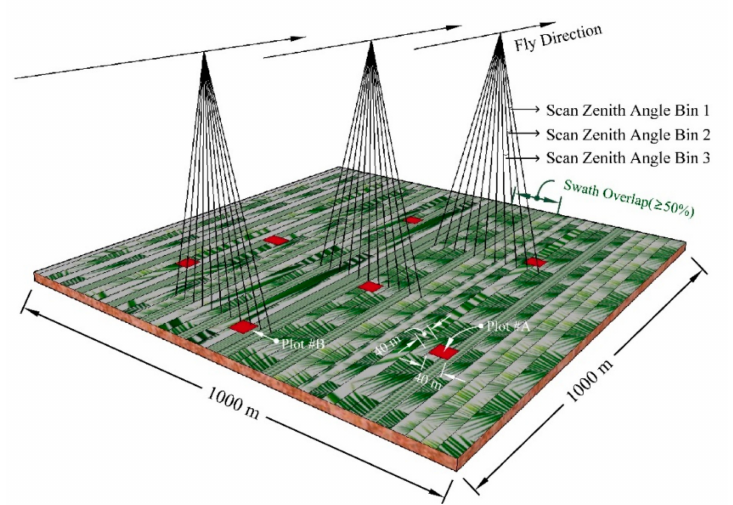
Figure 2. Sketch plot for the calculation of the angular gap fraction from tile-level (1 × 1 km 2 ) LiDAR data. The bin size of the scan zenith angle was set as 3 degrees. The plots (40 × 40 m 2 ) corresponding to the field measurements are indicated as a red